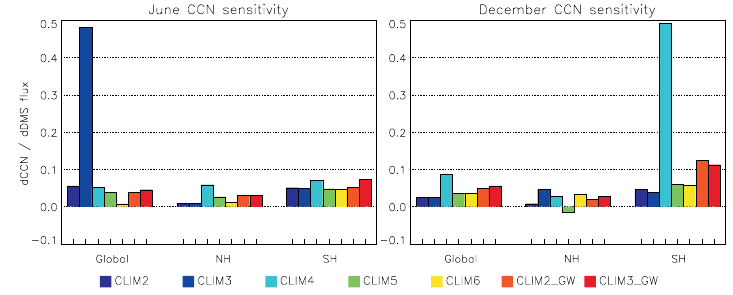
Fig. 9. June, and December relative CCN sensitivities for the five present day climatologies, relative to CLIM1 with the Kettle and Andreae (2000) climatology, and for the GW scenarios relative to CLIM2 and CLIM3.